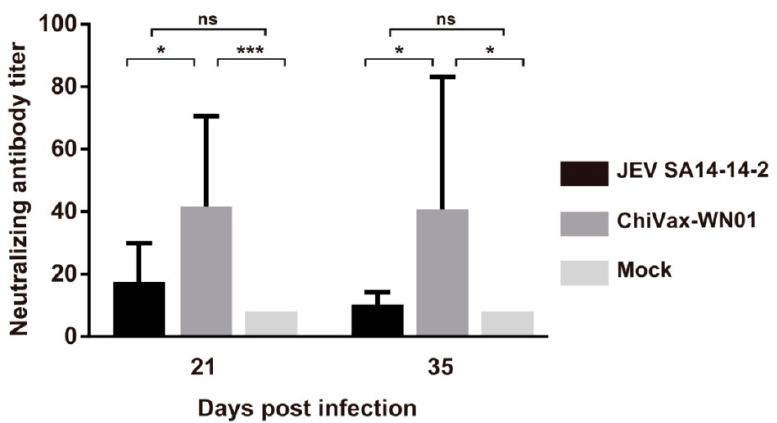
Figure 5. Neutralizing antibody titer. Four-week-old BALB/c mice ( n = 10) were inoculated with JEV SA14-14-2 or ChiVax-WN01 at 100 PFU i.p., respectively. The blood was collected 21 d and 35 d post infection for detecting antibody titers by viral neutralizing assay (VNA). Data are shown as the means ± SDs and were analyzed by one-way ANOVA (* p < 0.05, *** p < 0.001).